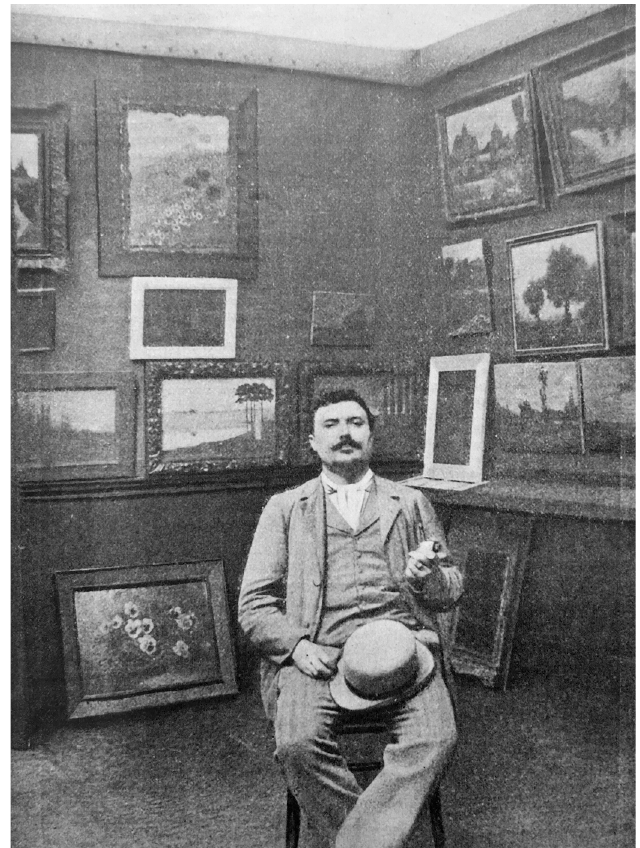
Léon Deschamps in the Salon des Cent, La Plume (15 February 1900), p.